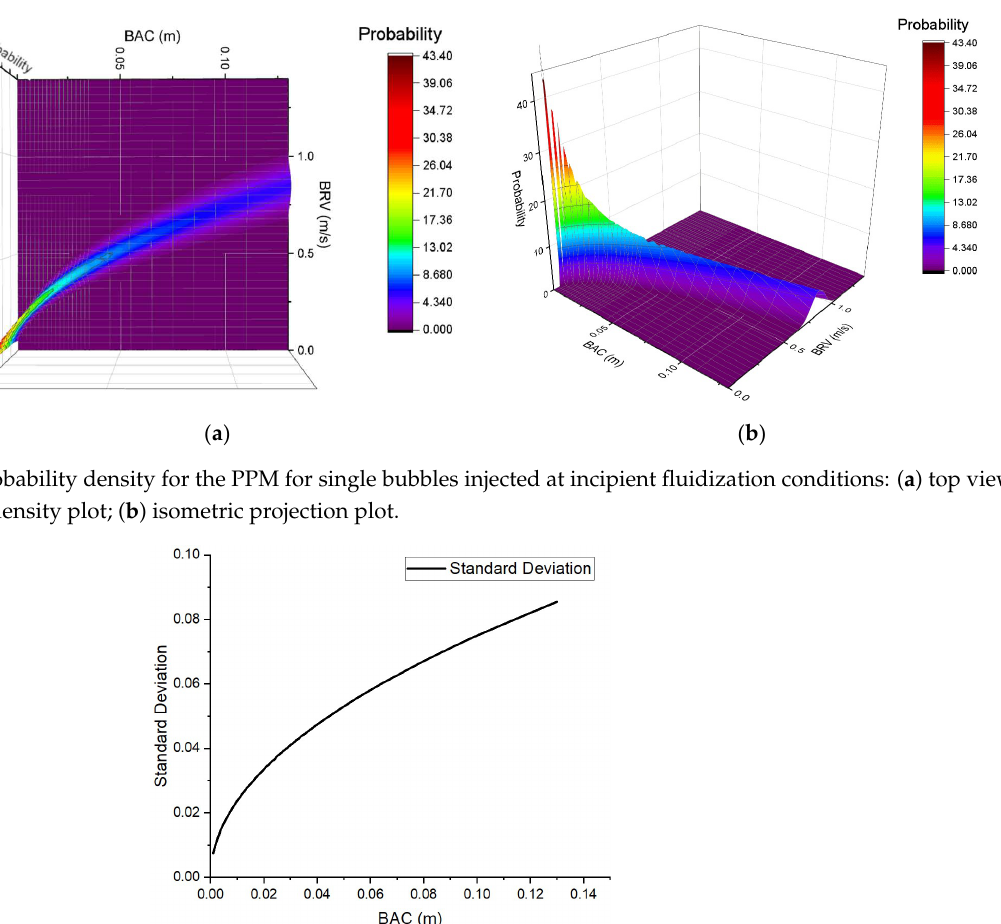
Figure 5. Probability distribution standard deviation changes with the BAC.